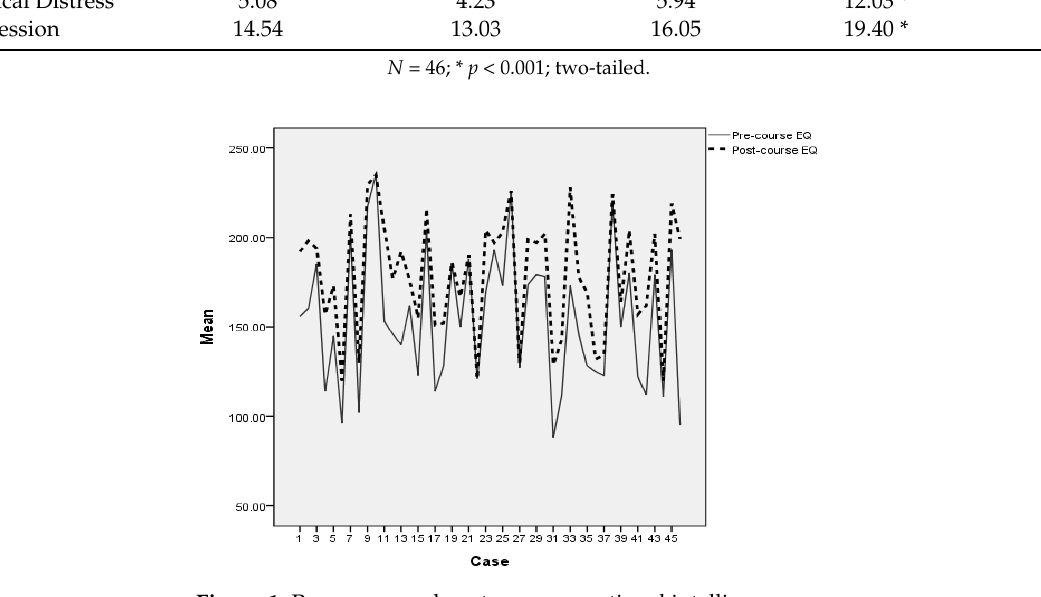
Figure 1. Pre-course and post-course emotional intelligence scores.